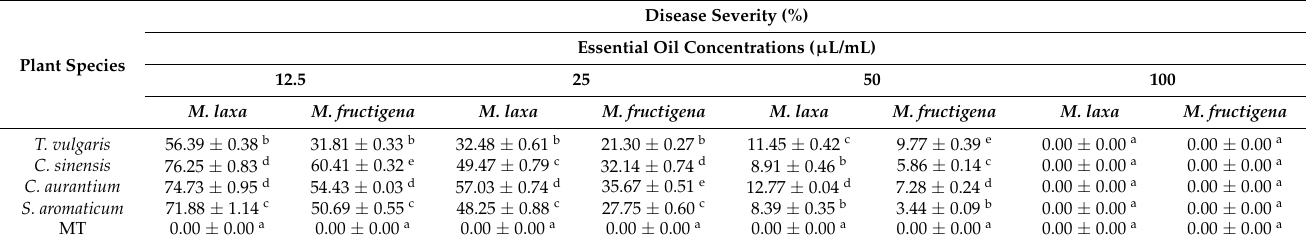
Table 4. In vivo effect of essential oils on mycelial growth of Monilinia laxa and Monilinia fructigena incubated at 25 ◦ C for 10 days.